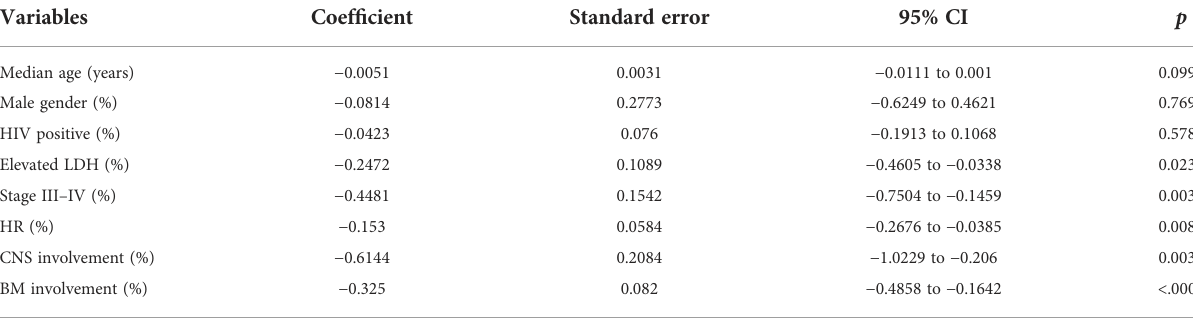
TABLE 3 Meta ‐ regression analysis in relation to 2 ‐ year OS